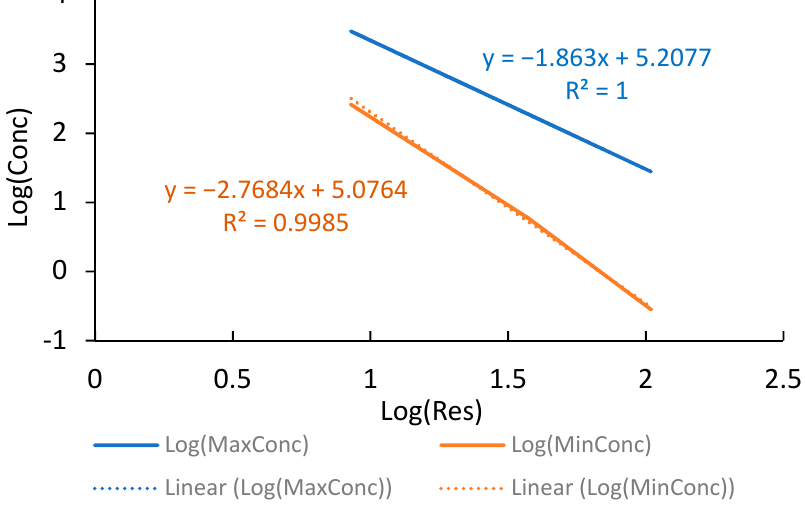
Figure 6. Maximum and minimum concentrations curves, replotted as log(Res) versus log(Conc) and fitted to linear equations.